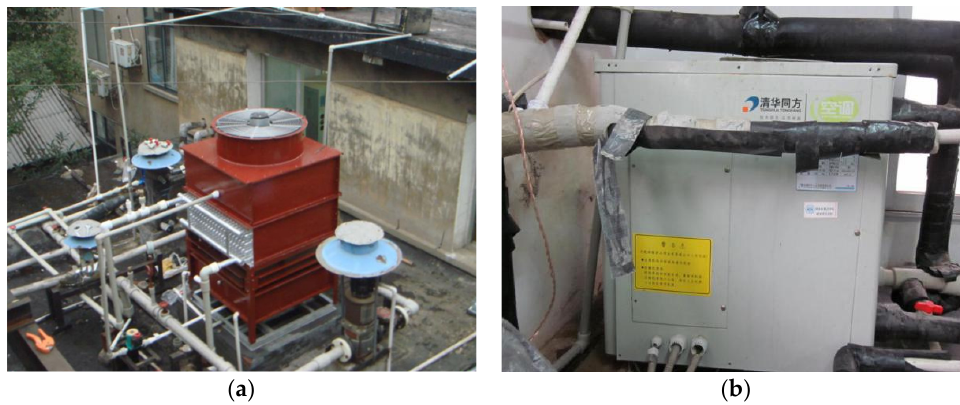
Figure 3. Photo of experimental device: ( a ) heat-source tower ( b ) water source heat pump. Table 2. The relevant parameters of heat-source tower heat exchanger.